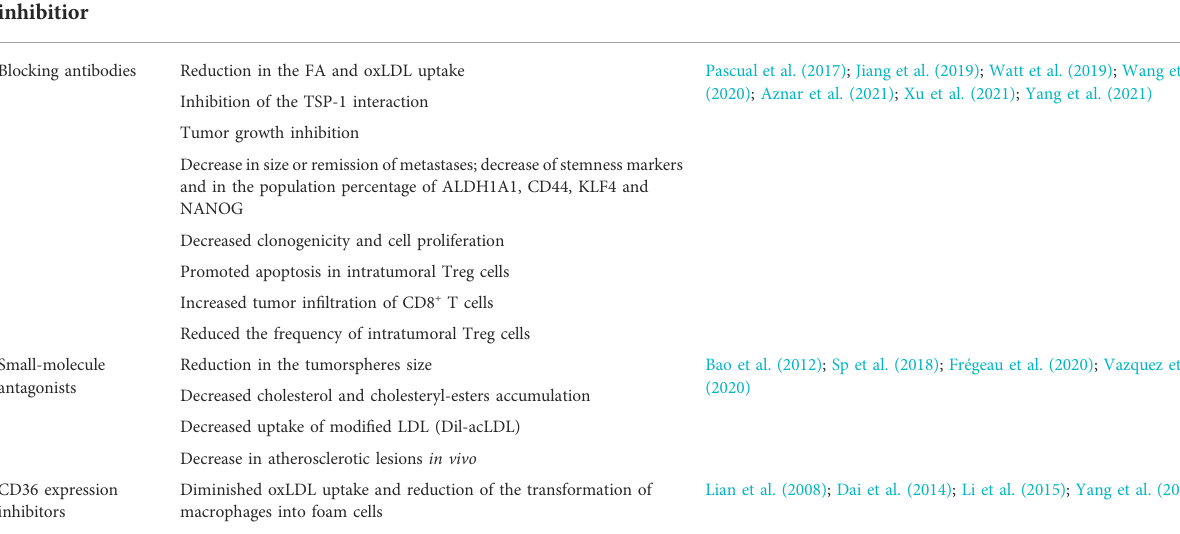
TABLE 2 Strategies for blocking CD36 and their reported